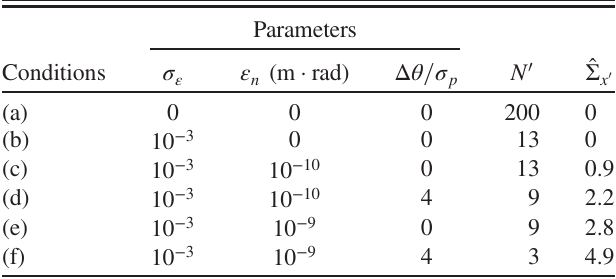
TABLE I. Parameters to represent the recovery factors sup- posed in the conditions (a) – (f). Note that the parameters N 0 and ˆ Σ N ¼ 200 and k ¼ 15 x 0 for each condition are those for